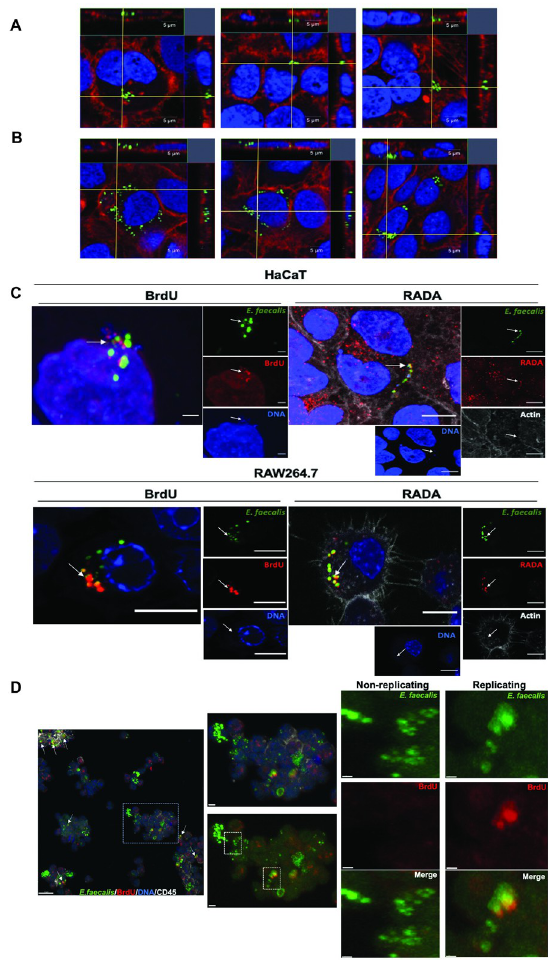
Fig 3. Intracellular E . faecalis replicates in vitro in HaCaT and RAW264.7 cells and in vivo in CD45-negative cells. (A) CLSM orthogonal view of internalized E . faecalis within HaCaT keratinocytes at 4 hpi (3 h infection + 1 h antibiotic treatment). (B) CLSM orthogonal view of internalized E . faecalis within HaCaT keratinocytes at 24 hpi (3 h infection + 21 h antibiotic treatment). (A, B) Blue, dsDNA stained with Hoechst 33342; green, E . faecalis ; red, F-actin. Images are representative of 3 independent experiments. Scale bar: 5 μ m (C) CLSM view of internalized E . faecalis stained with BrdU and RADA. Examples of replicating E . faecalis are indicated with a white arrow. Blue, dsDNA stained with Hoechst 33342; green, E-GFP, E . faecalis ; red, BrdU or RADA; white, F-actin. Images are representative of at least 3 independent experiments. Scale bar: 10 μ m. (D) CLSM view of ex vivo murine wound tissue cells following infection and BrdU treatment. Left panel shows examples of potentially replicating E . faecalis clusters, indicated with white arrows. Scale bar: 10 μ m. Right panels show magnified areas of interest. The marked areas with dashed lines white square show CD45-negative E . faecalis containing cells. Scale bars: 2 μ m and 0.5 μ m. Blue, dsDNA stained with Hoechst 33342; green, E . faecalis ; red, BrdU; white, CD45. Images are representative of 3 independent experiments. ( S1 Video shows a 3D video projection of this image. Additional images of ex vivo cell experiments are provided in S6 Fig ).